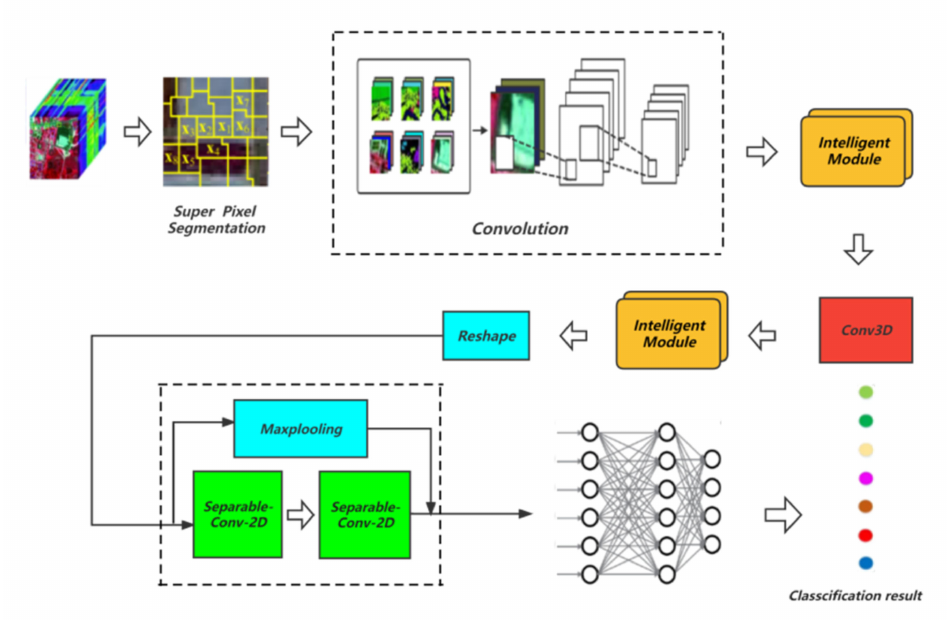
Figure 2. Schematic diagram of model